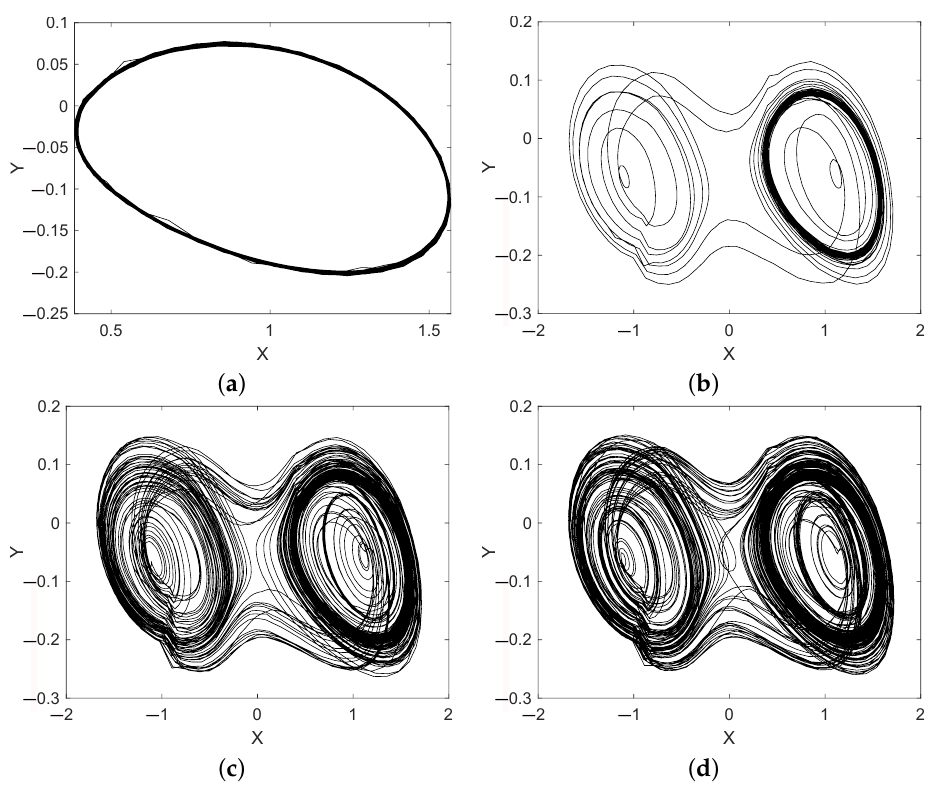
Figure 19. The Duffing oscillator attractors acquired from the sensitive circuit at different distances between the sensing coil and the square 25 × 25 cm brass plate: ( a ) 28 cm; ( b ) 27 cm; ( c ) 24 cm; and ( d ) 20 cm.